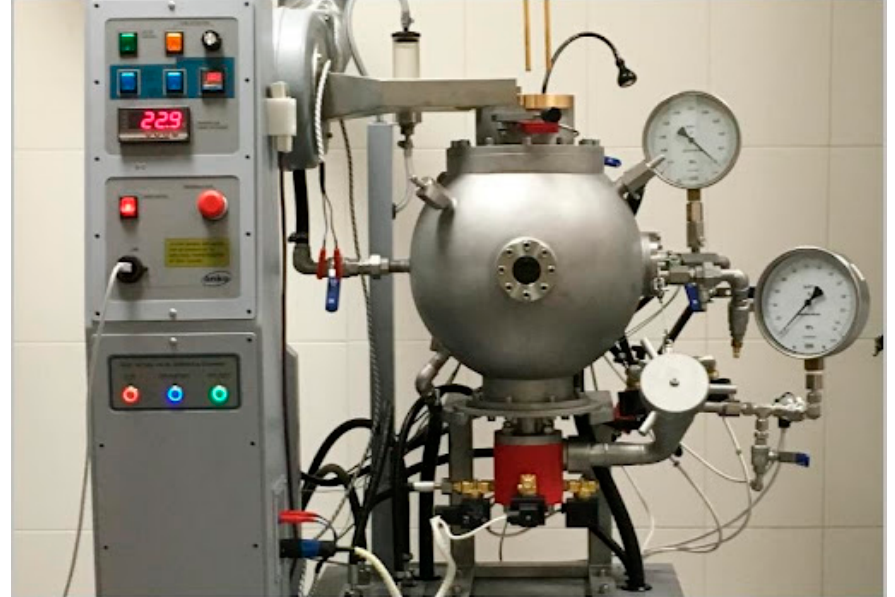
Figure 6. Twenty-liter spherical vessel manufactured by ANKO